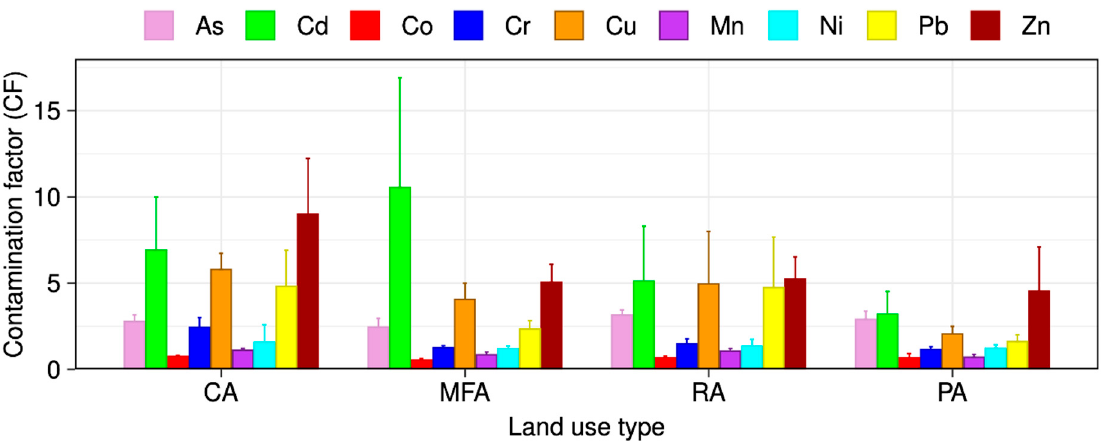
Figure 5. Contamination factor (CF) of each toxic metal (As, Cd, Co, Cr, Cu, Mn, Ni, Pb, and Zn) in road dust of Mymensingh City. CA = commercial areas, MFA = medically facilitated areas, RA = residential areas, PA = park areas.